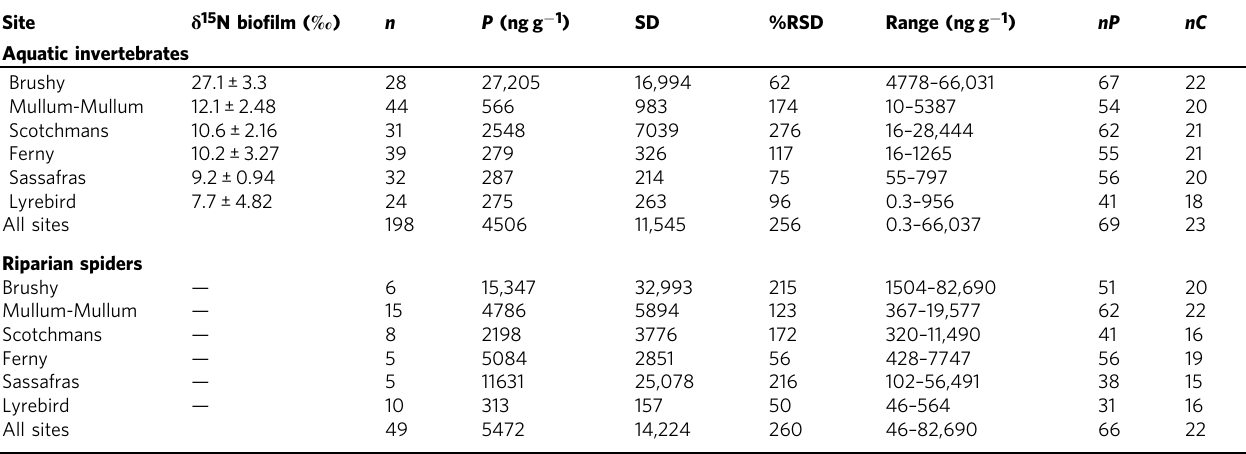
Average concentration of total pharmaceuticals (ngg − 1 dry weight) and range of total pharmaceutical concentration detected in aquatic invertebrate and spider tissues across all sites. Elevated δ 15 N of the bio fi lms ( n = 5) is an indicator of sewage contamination in streams P average pharmaceutical concentration, n number of samples, nP number of pharmaceutical compounds, nC number of therapeutic classes, and range (ng g − 1 ) minimum and maximum concentrations observed in